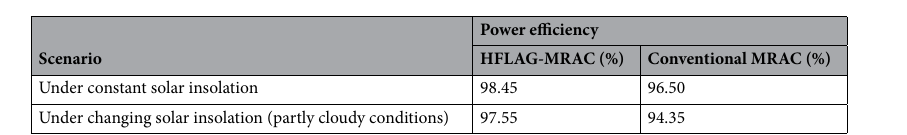
Table 6. Power efficiency under different environmental